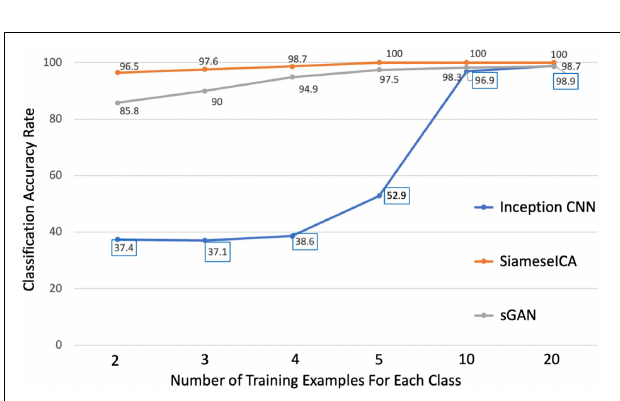
FIGURE 5 | Plots of classification accuracy with different number of training examples for the inception CNN, sGAN and the proposed SiameseICA